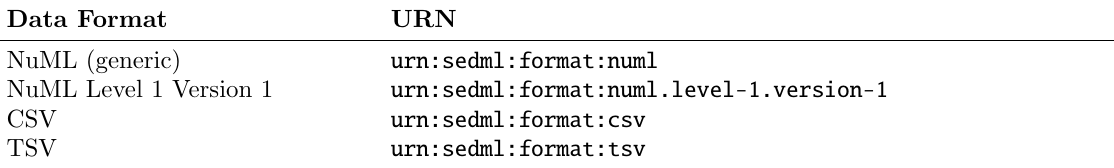
Table 3.2: Predefined dataDescription format URNs. The latest list of format URNs is available from http://sed-ml.org/